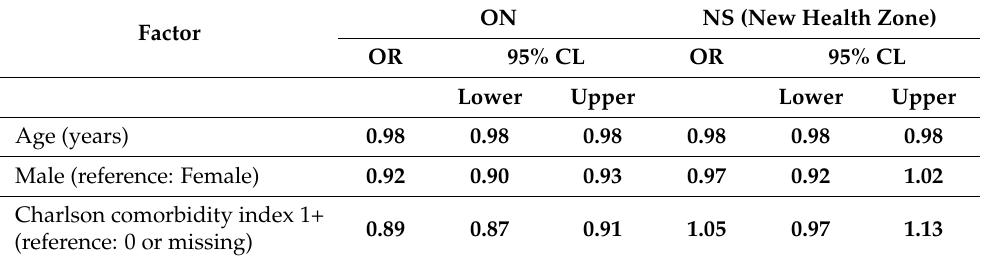
Table A4. Multivariable logistic regression model for supportive care,